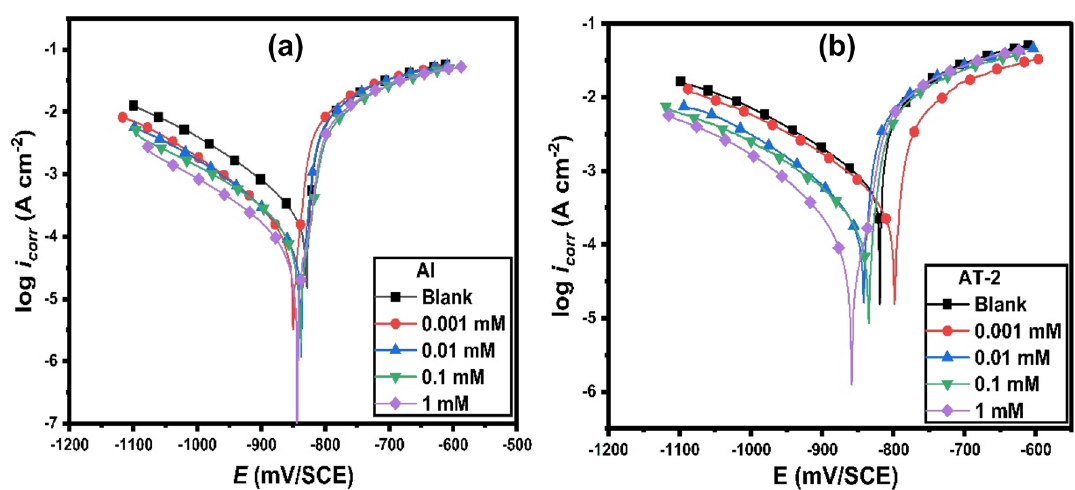
Figure 2. Tafel polarizations for ( a ) Al and ( b ) AT-2 alloy in 0.5 M HCl in the absence and presence of various concentrations of 2-MBT at 25 polarization in the presence of 2-MBT concentrations in the case of Al and AT-2 alloy. In this context, Table 2 shows the experimental results derived from the polarization curves with adding various concentrations of 2-MBT. The i corr for the tested metal and its alloys in the presence and absence of the inhibitor has been estimated by extrapolating the cathodic and anodic lines of the Tafel polarization curve to the E corr . The presence of 2-MBT causes a decrease in both the anodic and cathodic branches of the polarization curves. However, the data exhib- ited that the inhibition action in the cathodic process is higher than in the anodic one. The anodic and cathodic potentials against current density were employed to compute the corrosion parameters. Because b c and b a remain nearly unchanged in Table 2 compared to uninhibited solutions, the inhibitory action of 2-MBT does not alter the hydrogen evolution mechanism 38 . On the other side, it has been discovered